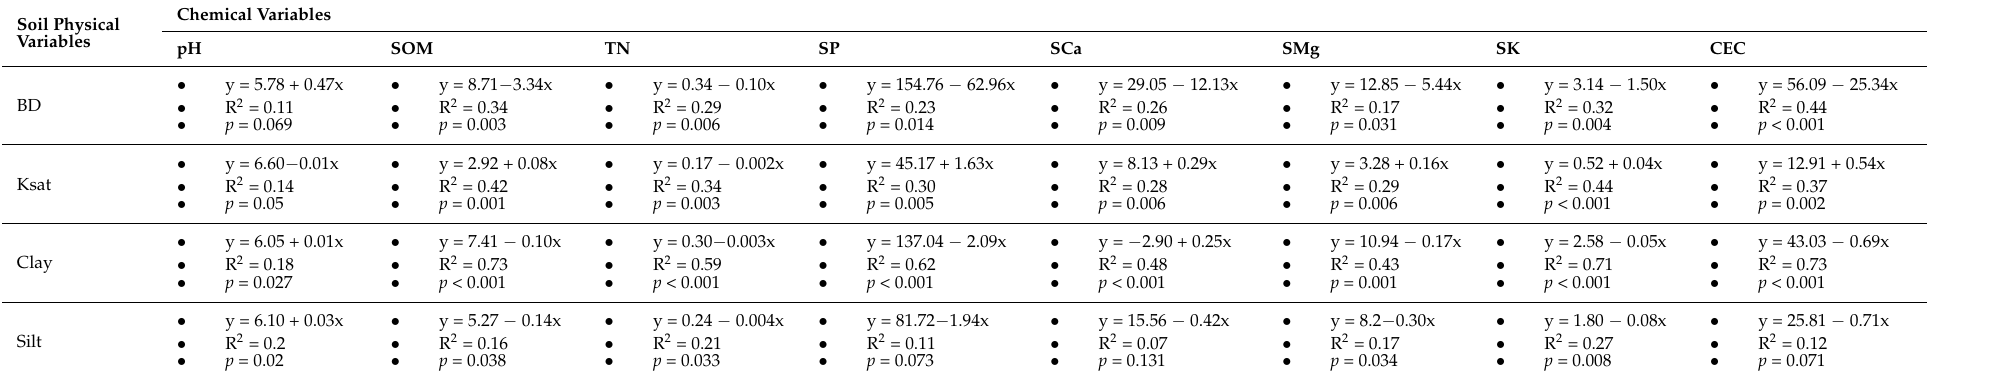
Table 5. Coefficients of determination (R 2 ) and regression models for relating soil chemical and physical